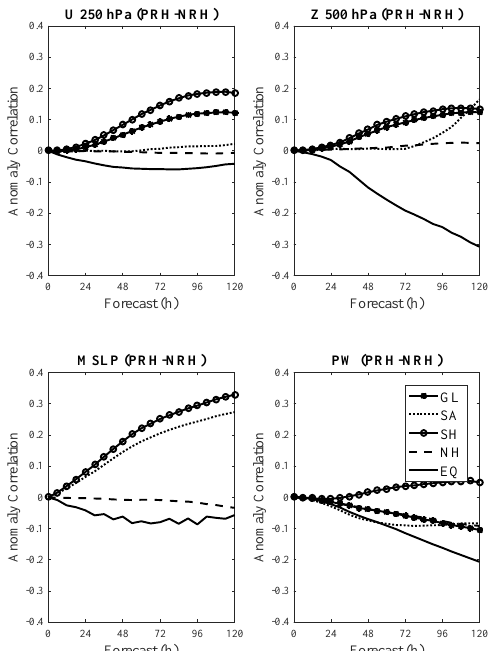
Figure 6. Differences in the anomaly correlation as a function of the model integration time for the zonal wind component at 250 hPa, 500 hPa geopotential height, mean sea level pressure and water precipitable for global domains, Southern Hemisphere, Northern Hemisphere, Equator region and South